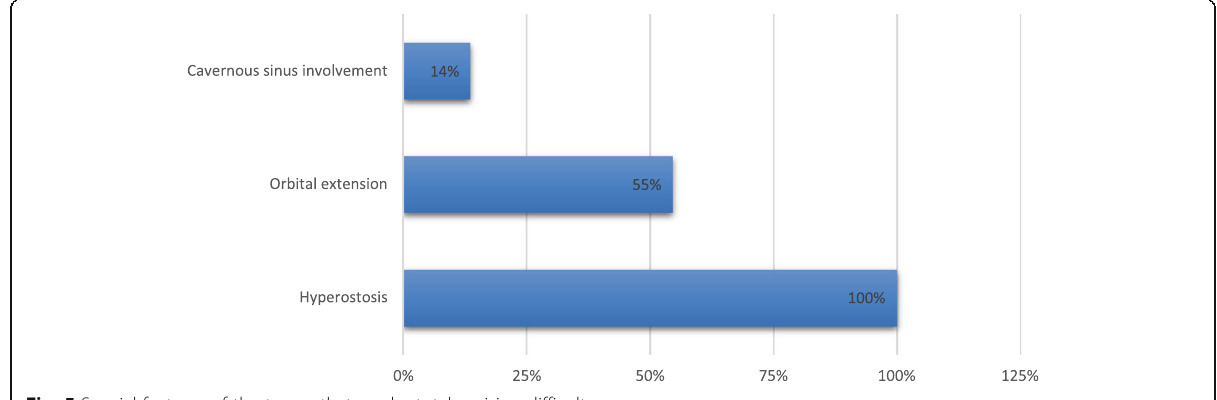
Fig. 5 Special features of the tumor that render total excision